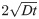
Principle behind diffusion chronometry.We use a 1D model to calculate the time since the inception of a given compositional contact in a crystal. We assume an initially infinitely sharp “step function” boundary (indicated as “Initial condition” in the diagram), which becomes progressively less sharp with time (shown as a series of curves). This problem has a well-known solution, with the resulting damped curve being described by a complementary error function (erfc) as shown in the figure. We use a least-squares procedure to find the best-fit erfc function, from which we can extract the value of (2Dt); using experimentally determined values of the diffusion coefficient D, we can then calculate the residence time of a given contact and the growth time for the crystal region rimward from the contact. We can also measure the growth distance from our images, from which we calculate average crystal rim growth rates.